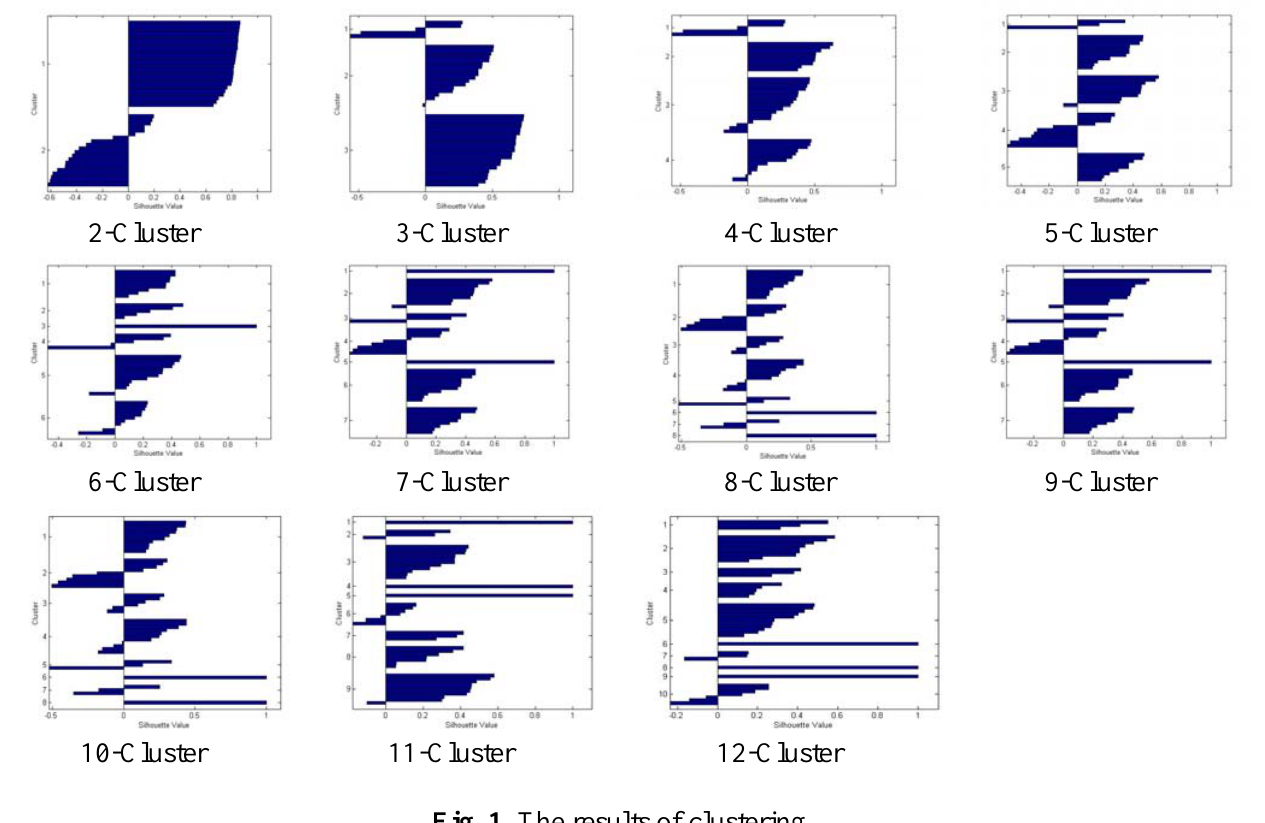
Fig. 1. The results of